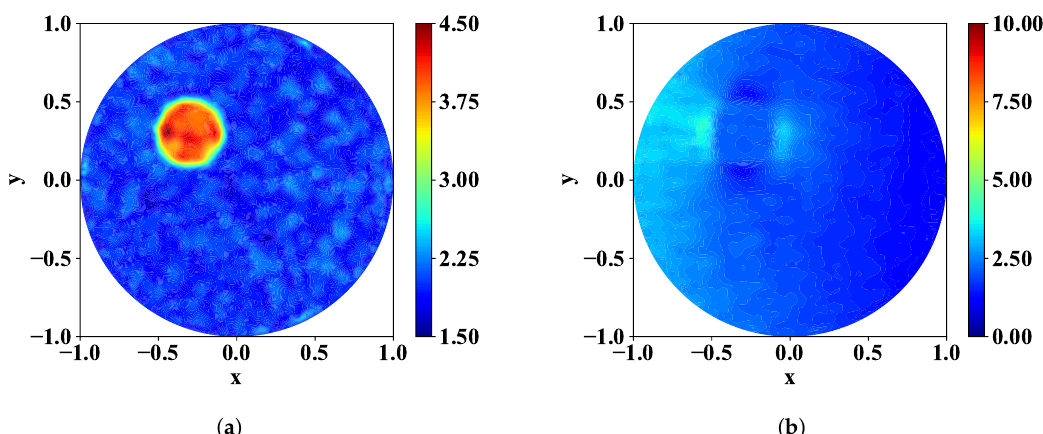
Figure 11. When SNR = 20 dB, σ = 4.0S/m and the step is 5: ( a ) the reconstructed image and ( b ) the power density.